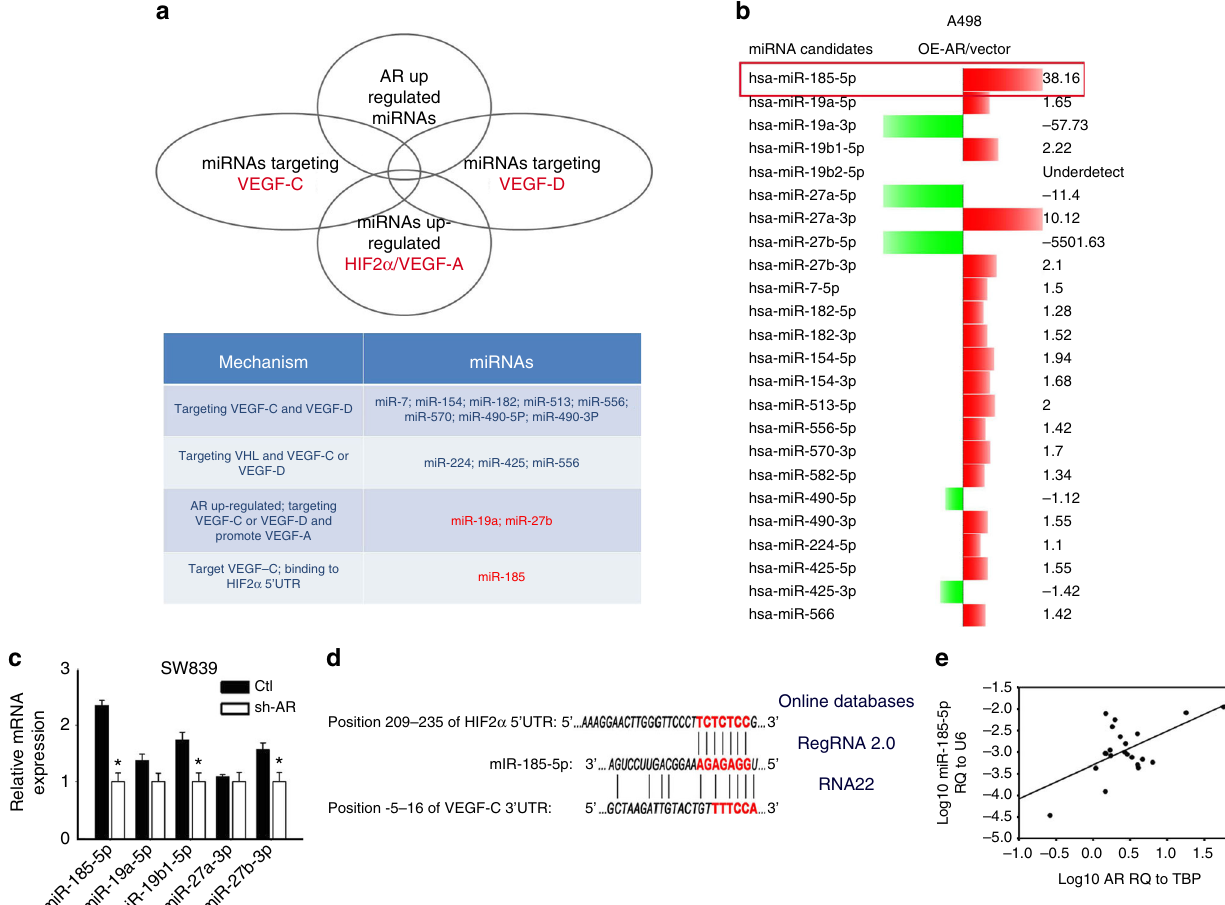
Fig. 4 AR regulates HIF2 α and VEGF-A vs. VEGF-C via miR-185-5p. a The strategy to screen miRNAs ( upper ) and mechanisms of the miRNAs selected ( lower ). b Right columns and positive values represent increase while left columns and negative values represent decrease, and the number equals the fold change. The response to AR overexpression of potential miRNAs was examined in A498 cells. c qPCR to screen miRNAs regulated by AR-knockdown in SW839 cells. Triplicate experiments were carried out. * p < 0.05 was considered statistically signi fi cant ( t -test). d Sequence alignment of miR-185-5p with HIF2 α promoter region (predicted by RegRNA2.0) and 3 ′ UTR of VEGF-C (predicted by RNA22). e Clinical association of AR expression with miR-185-5p expression in ccRCC tumors analyzed by linear regression ( p = 0.003, r = 0.600, n =